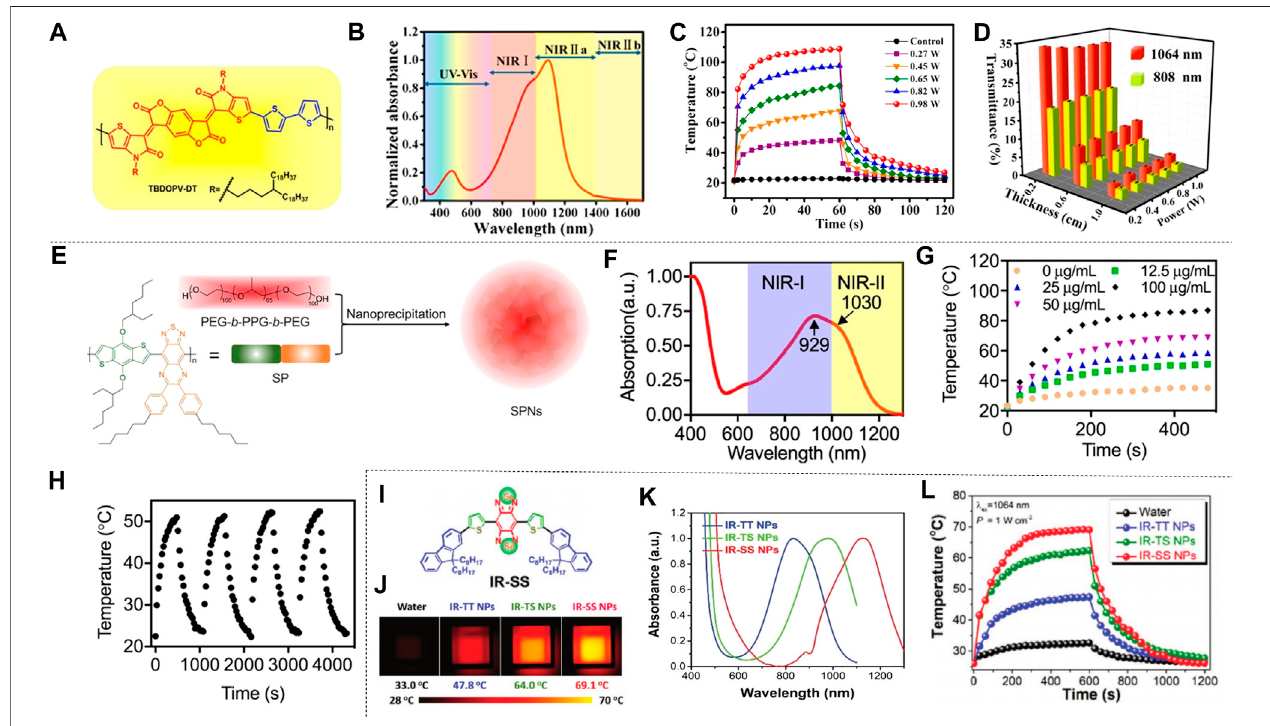
FIGURE 6 | Photothermal properties of polymer nanomaterials. (A) TBDOPV-DT ’ s chemical structure red markings for the receptor part, and blue for the donor part. (B) Standardized UV-vis-NIR spectrum of TBDOPV-DT membranes. The spectral regions are segmented into Vis (300 – 750 nm), NIR-I (750 – 1,000 nm), NIR- Ⅱ a (1,000 – 1,400 nm),andNIR- Ⅱ b(1,400 – 1700 nm). (C) Atdifferentpowerlevels,theTBDOPV-DT fi lm ’ ssurfacetemperatureisincreasedordecreasedbylighting.Usethe glass substrate with an uncoated TBDOPV-DT fi lm as a control sample. (D) Transmission comparison between 1,064 nm and 808 nm laser at different pig skin thicknesses(0.2,0.6and0.0 cm)anddifferentpowers(0.27,0.45,0.45,0.65and0.82 W)(reproducedfrom(Caoetal.,2016)withpermissionfromAmericanChemical Society). (E) Description of the SPNs of SP and PEG-b-PPG-b-PEG was prepared by nanoprecipitation. (F) The SPNs absorption spectra measured in an